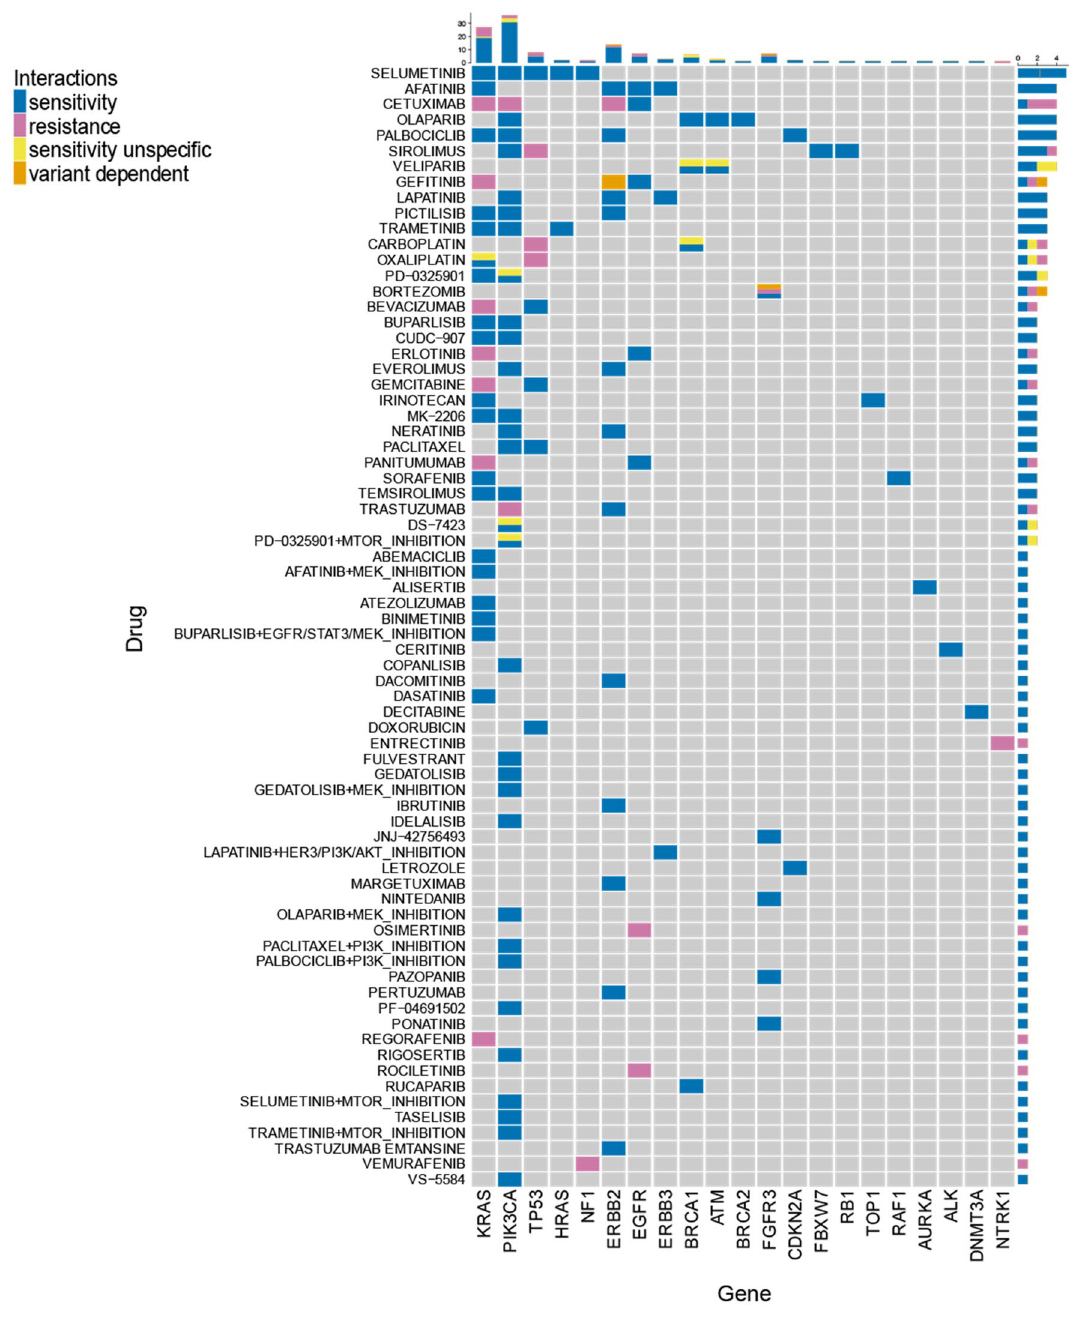
Figure 6. Our drug response prediction workflow discovers a panel of genes and related drugs/drug- combinations for personalized therapy in bladder cancer. The figure illustrates the final selection of drug-gene interactions (including combination treatments). “Sensitivity” and “resistance” refer to predicted sensitivity and resistance when the associated gene contains a respective variant. “Sensitivity unspecific” refers to genes where sensitivity to a particular drug could not be assigned to a particular variant but multiple variants would lead to the prediction. In “variant dependent” predictions, different variants within one gene can cause a divergent direction of the response prediction (sensitivity/resistance). (R Core Team (2019). R: A language and environment for statistical computing. R Foundation for Statistical Computing, Vienna, Austria. https ://www.R- proje ct.org/) 57